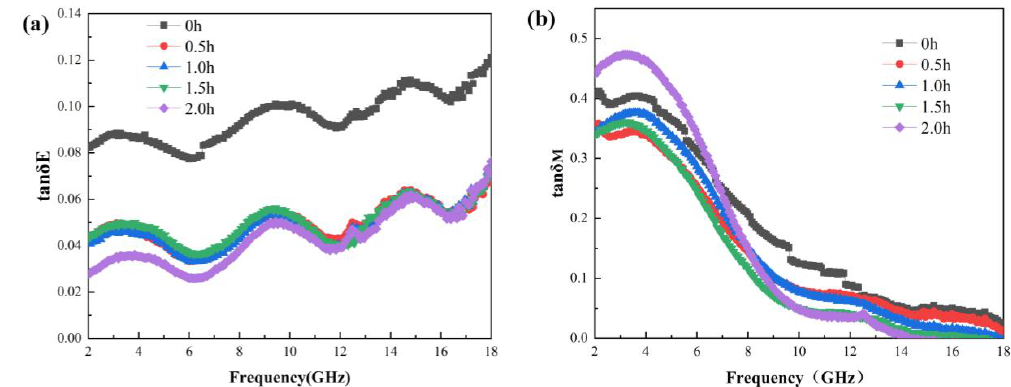
Figure 5. Electric loss tangent and magnetic loss tangent of the Fe 3 O 4 absorption material at different grinding times. ( a ) Dielectric loss tangent; ( b ) Magnetic loss